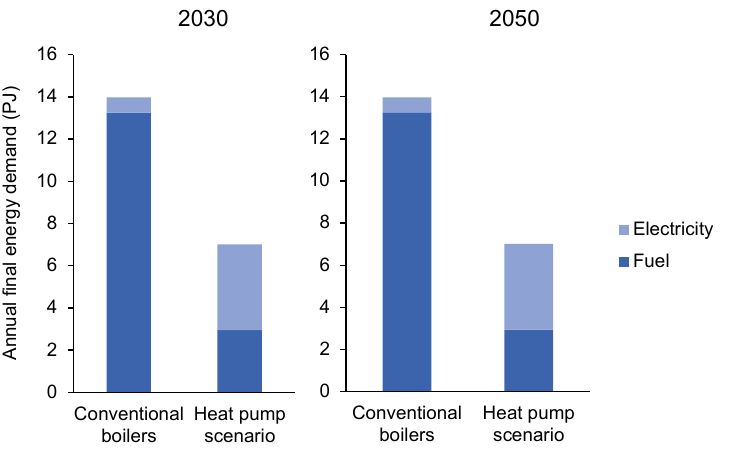
Figure 8. Annual final energy demand in the textile wet-processing industry in Japan .